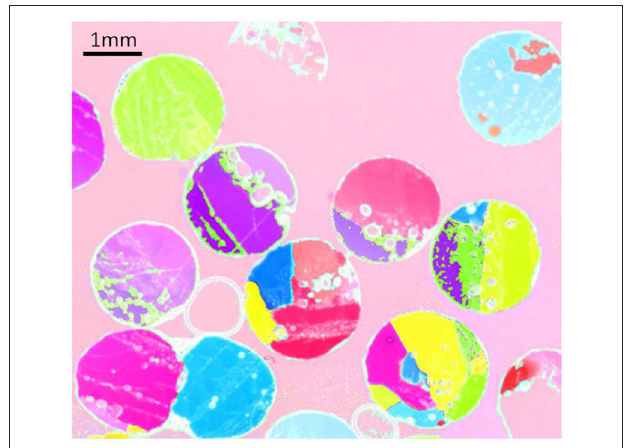
FIGURE 4 | Visualization of crystalline structure of several ice beads, ground to 50 µ m thick slices. A mono-crystal is represented by one